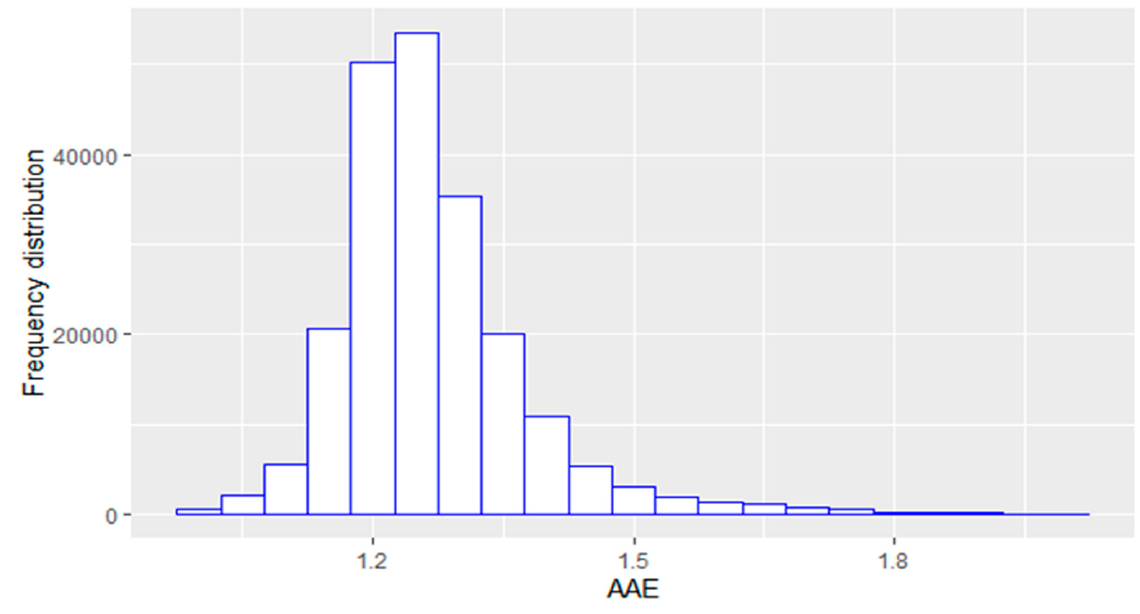
Figure 3. Frequency distribution of the aerosol absorption Ångström exponent (AAE) derived from absorptions at 470 nm and 950 nm.